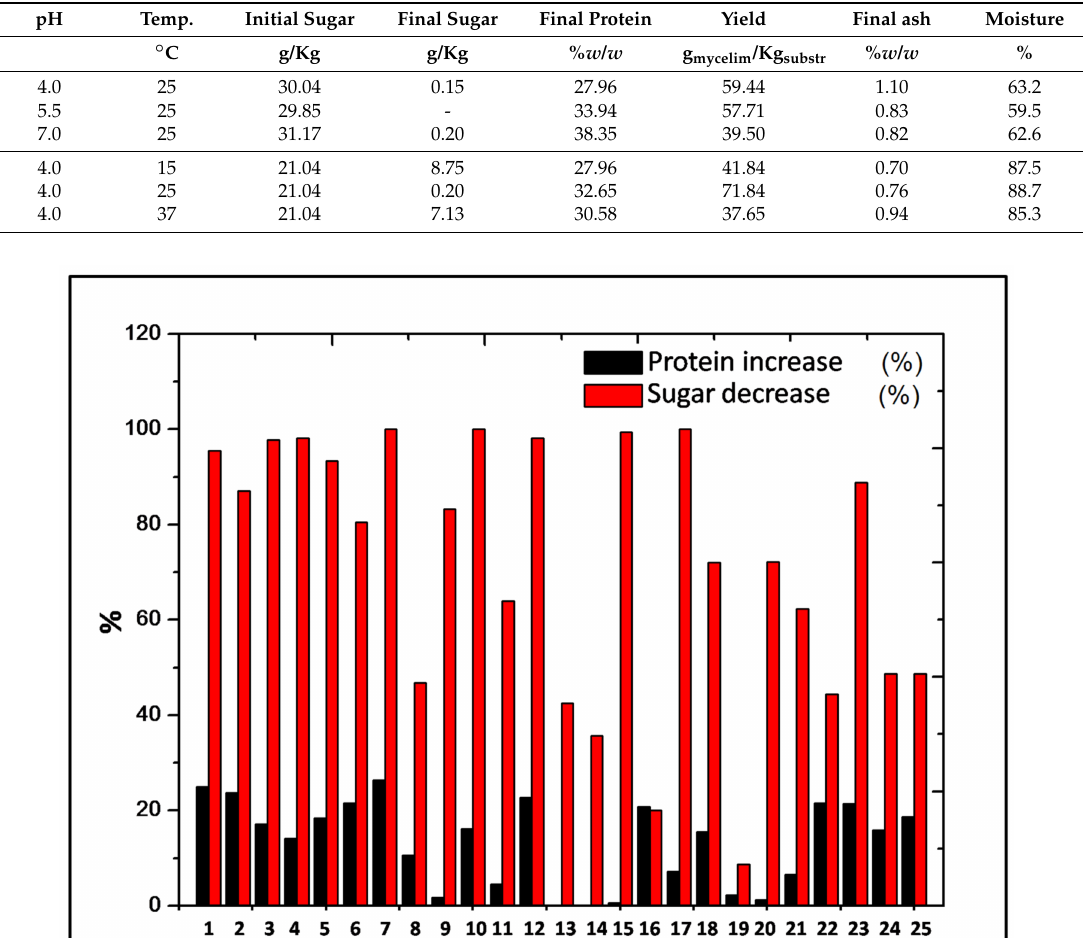
Table 3. Effect of temperature (15, 25, and 37 ◦ C) and pH (4.0, 5.5, and 7.0) on P. ostreatus growth in S7 by SSF.